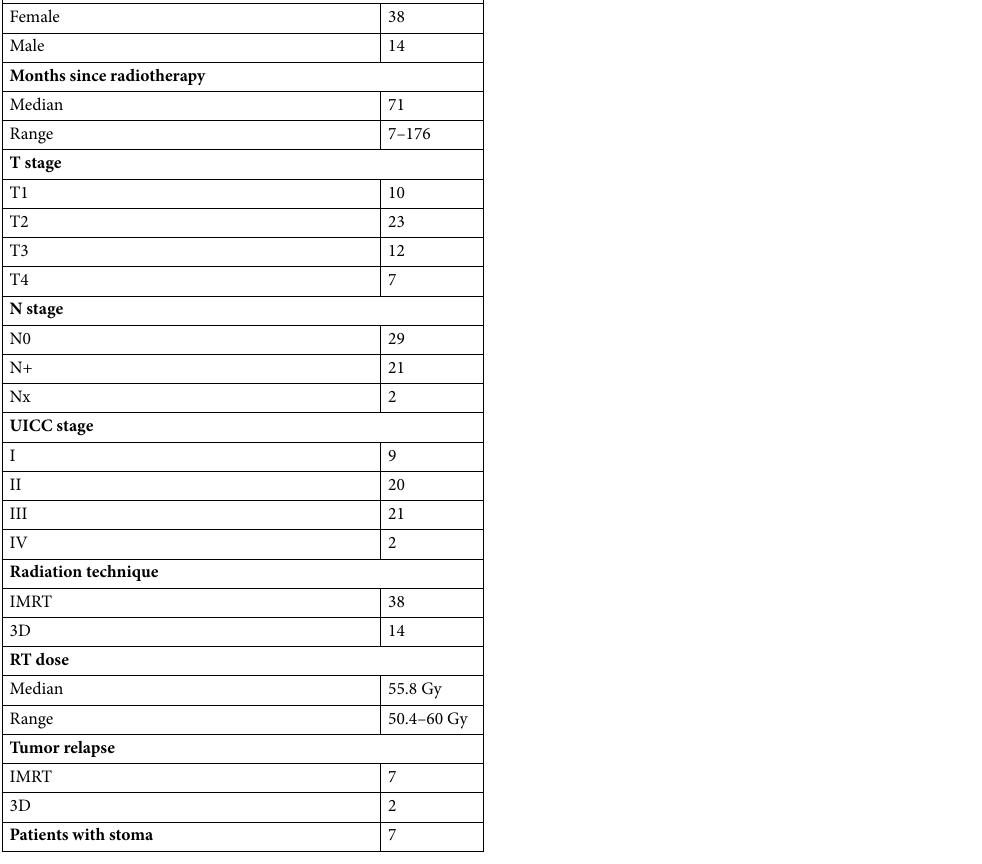
Table 1. Patient characteristics.